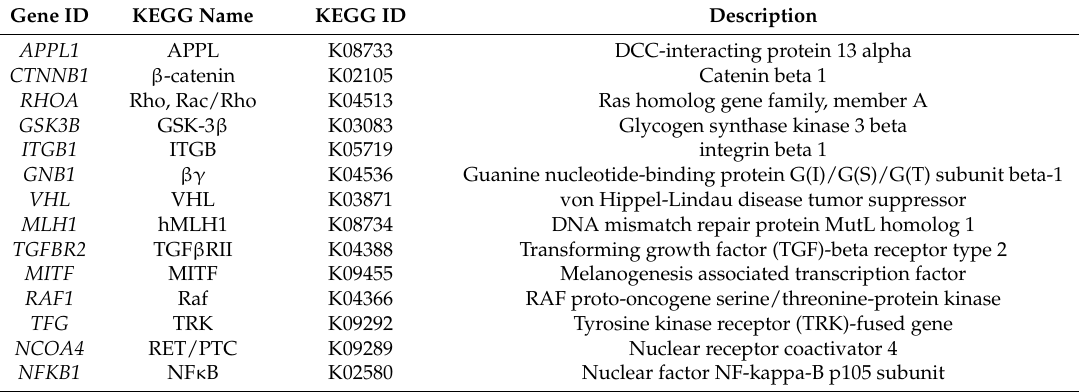
Table 1. ADAR1-p110-bound transcripts present in KEGG Pathways in Cancer (ko05200).